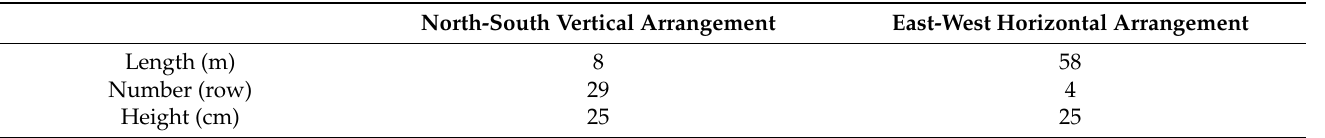
Table 2. Parameters of cultivation racks in the orientation arrangement